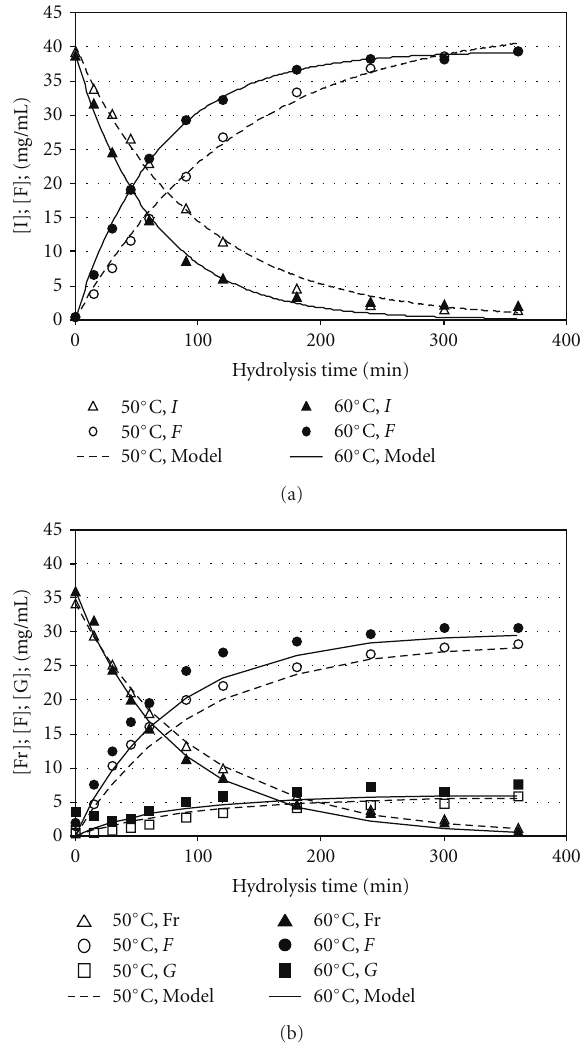
Figure 5: Kinetics of substrates degradation and sugars released as a function of hydrolysis time at di ff erent temperatures. (a) Chicory inulin, (b) Agave fructan. I : chicory inulin; Fr: agave fructan; F : fructose, G :